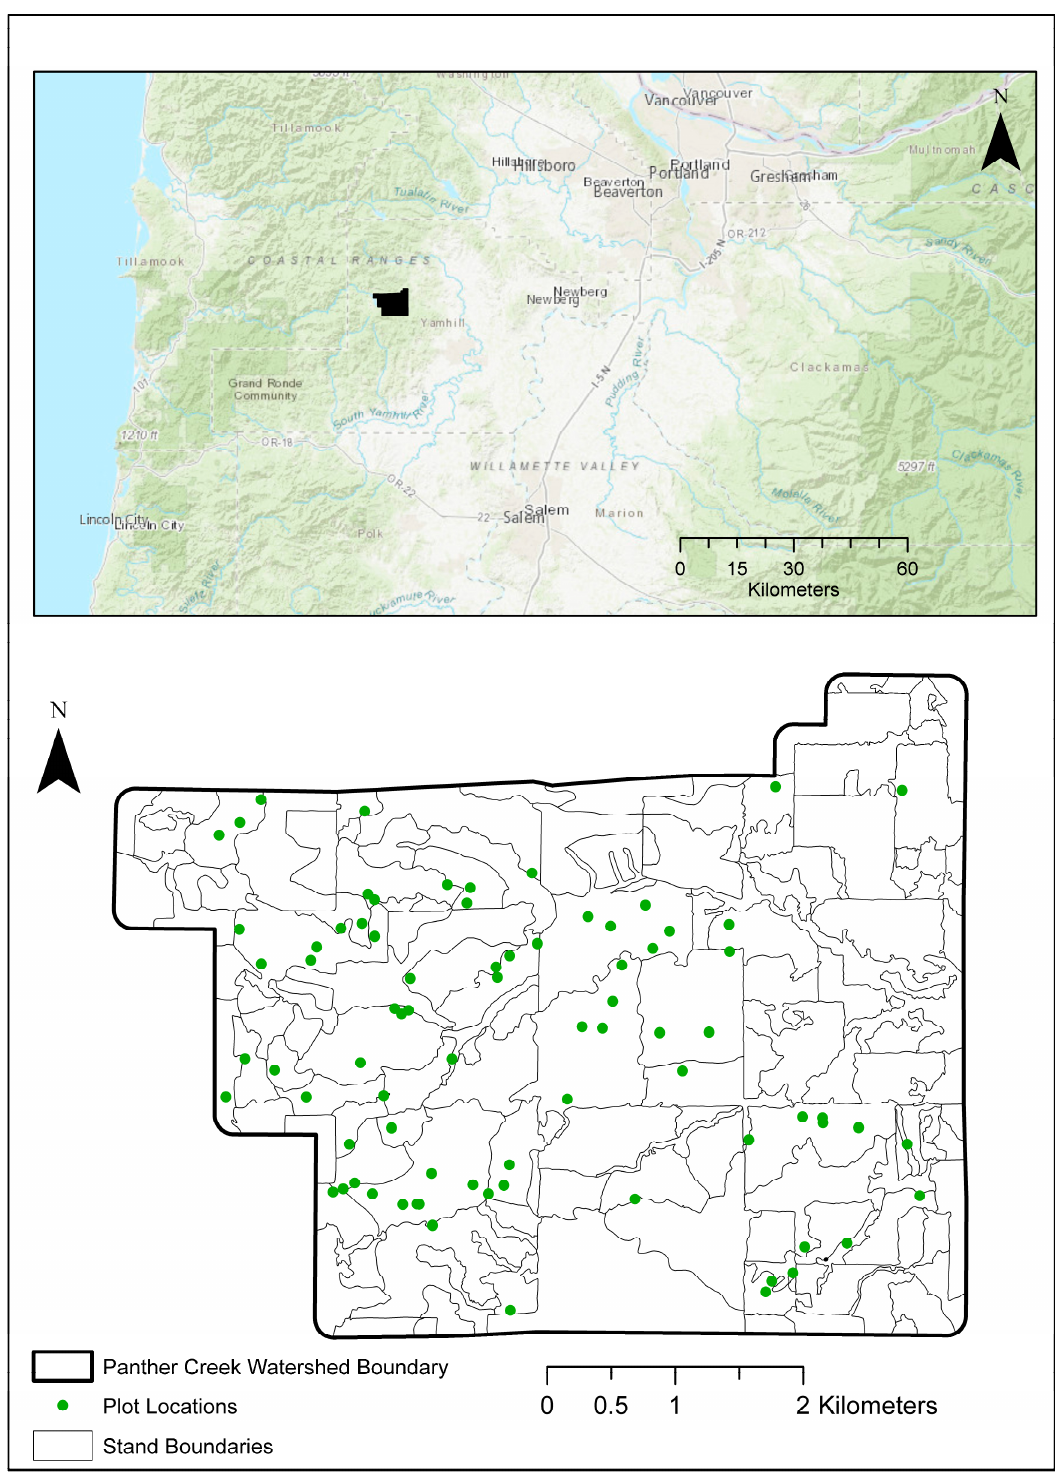
Figure 1. Map of the study area—the panther creek watershed.